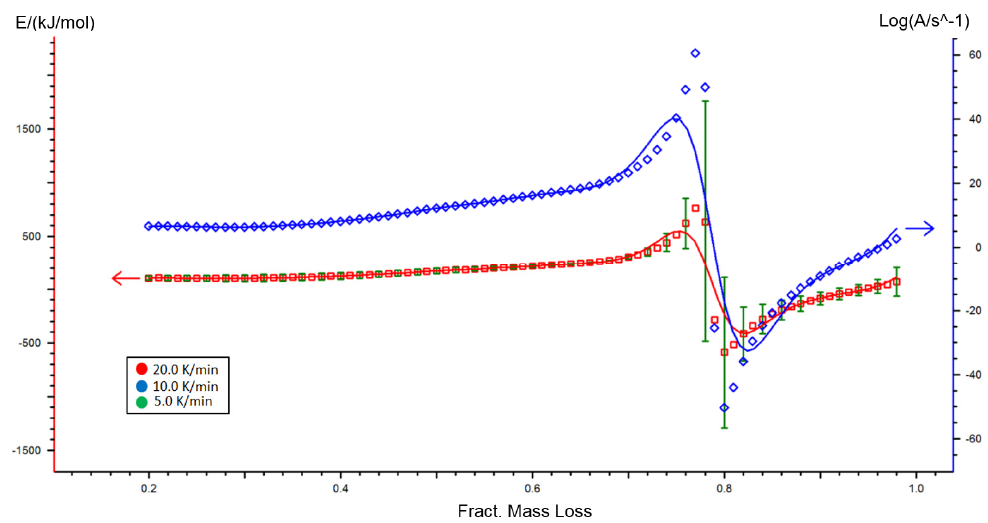
Figure A2. Activation energy and pre-exponential coefficient as a function of the degree of conversion by the Friedman method for Miscanthus.